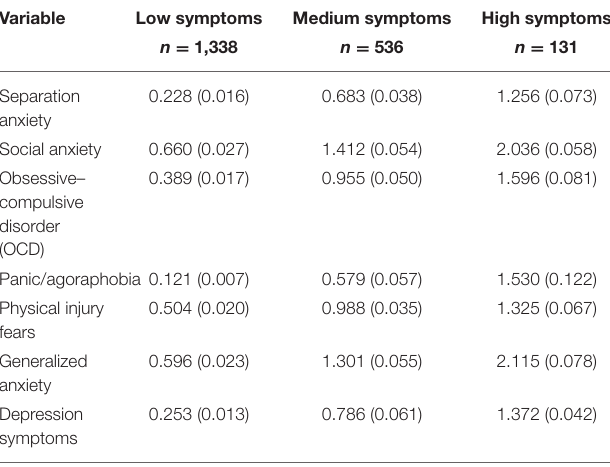
TABLE 3 | Mean scale scores for the three latent symptom